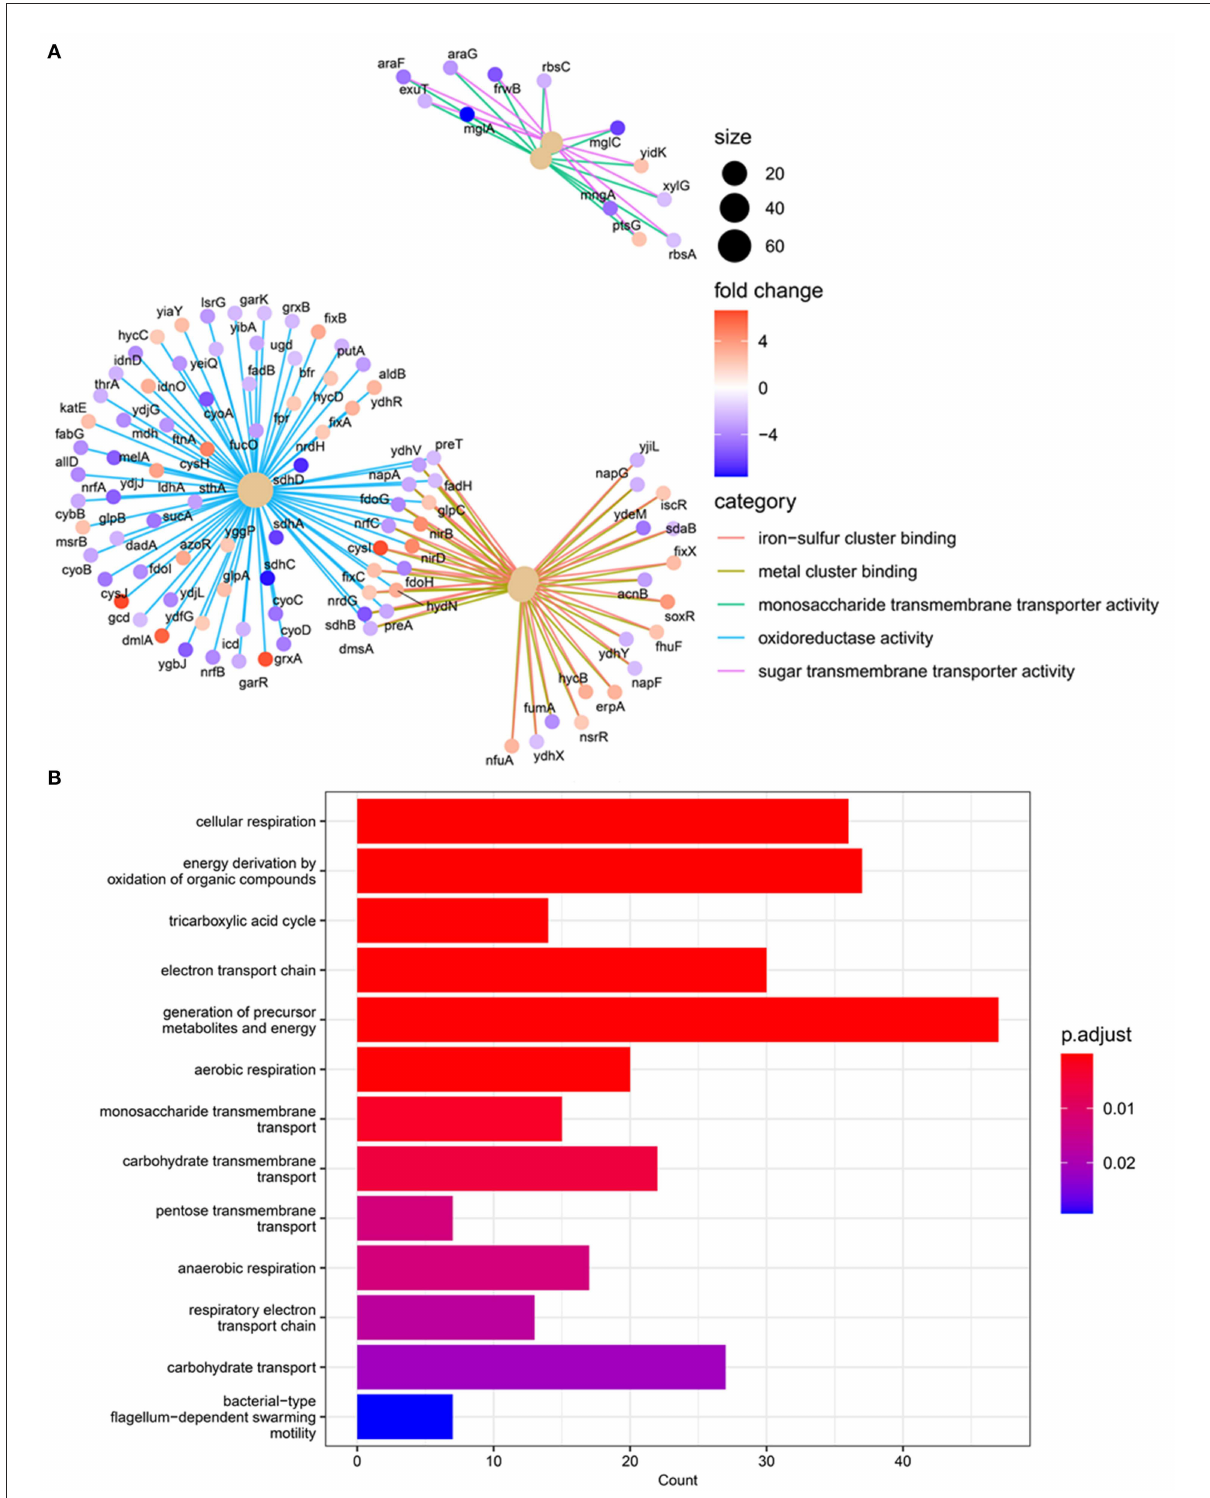
FIGURE5 Gene annotation enrichment analysis of GO pathway networking. (A) Differentially expressed genes (DEGs) and GO pathway enrichment analysis of the DEGs in the different treatments of 4 mg/mL of CRAN, and (4 µ g/mL AXO + 4 mg/mL CRAN) CC compared to control. The blue circle indicates downregulation, while the red circle indicates upregulation. The darker the color, the stronger the effect. These were combined from 10 different pathways, with none of the pathways providing more than three interactions. (B) Count of affected genes in each GO pathway. A log 2 -fold change of > 2 and false discovery rate (FDR) cutoffs ≤ 0.001 are